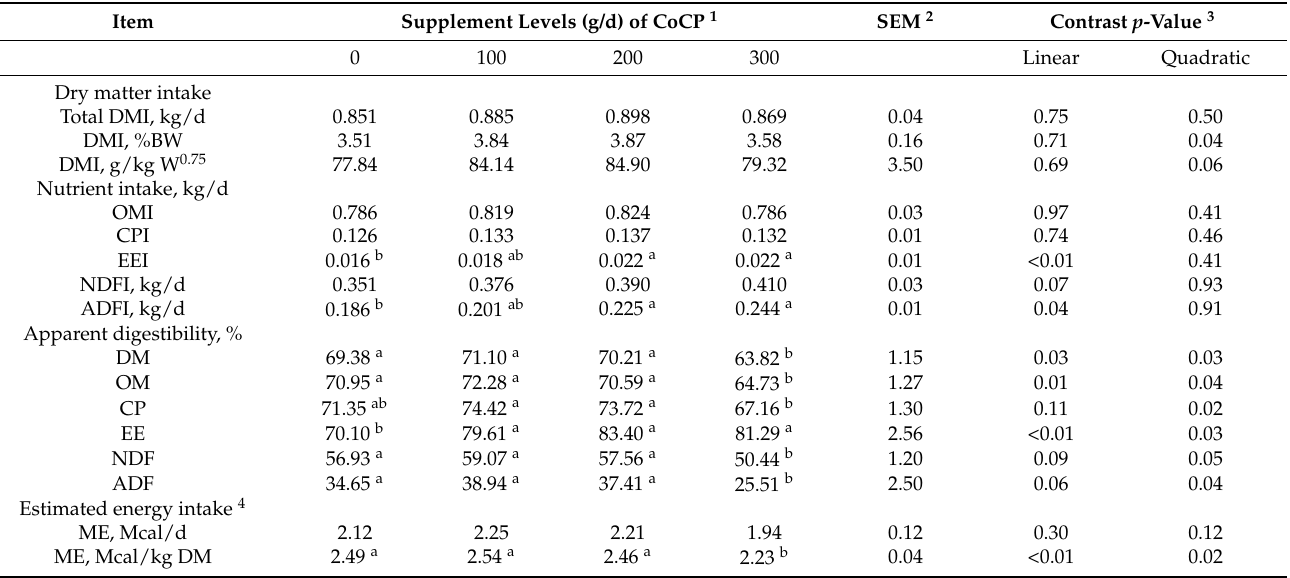
Table 2. Effects of dietary CoCP supplementation (g/d) on feed intake, nutrient intake, and apparent digestibility of nutrients in goats.